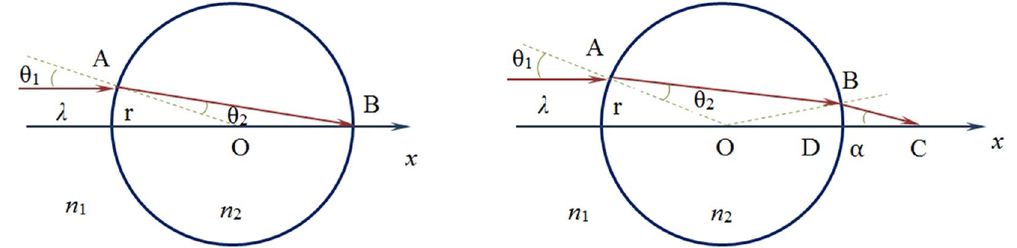
Figure 1. Schematic of a microsphere illuminated by optical needle with width of 0.43 λ 0 .